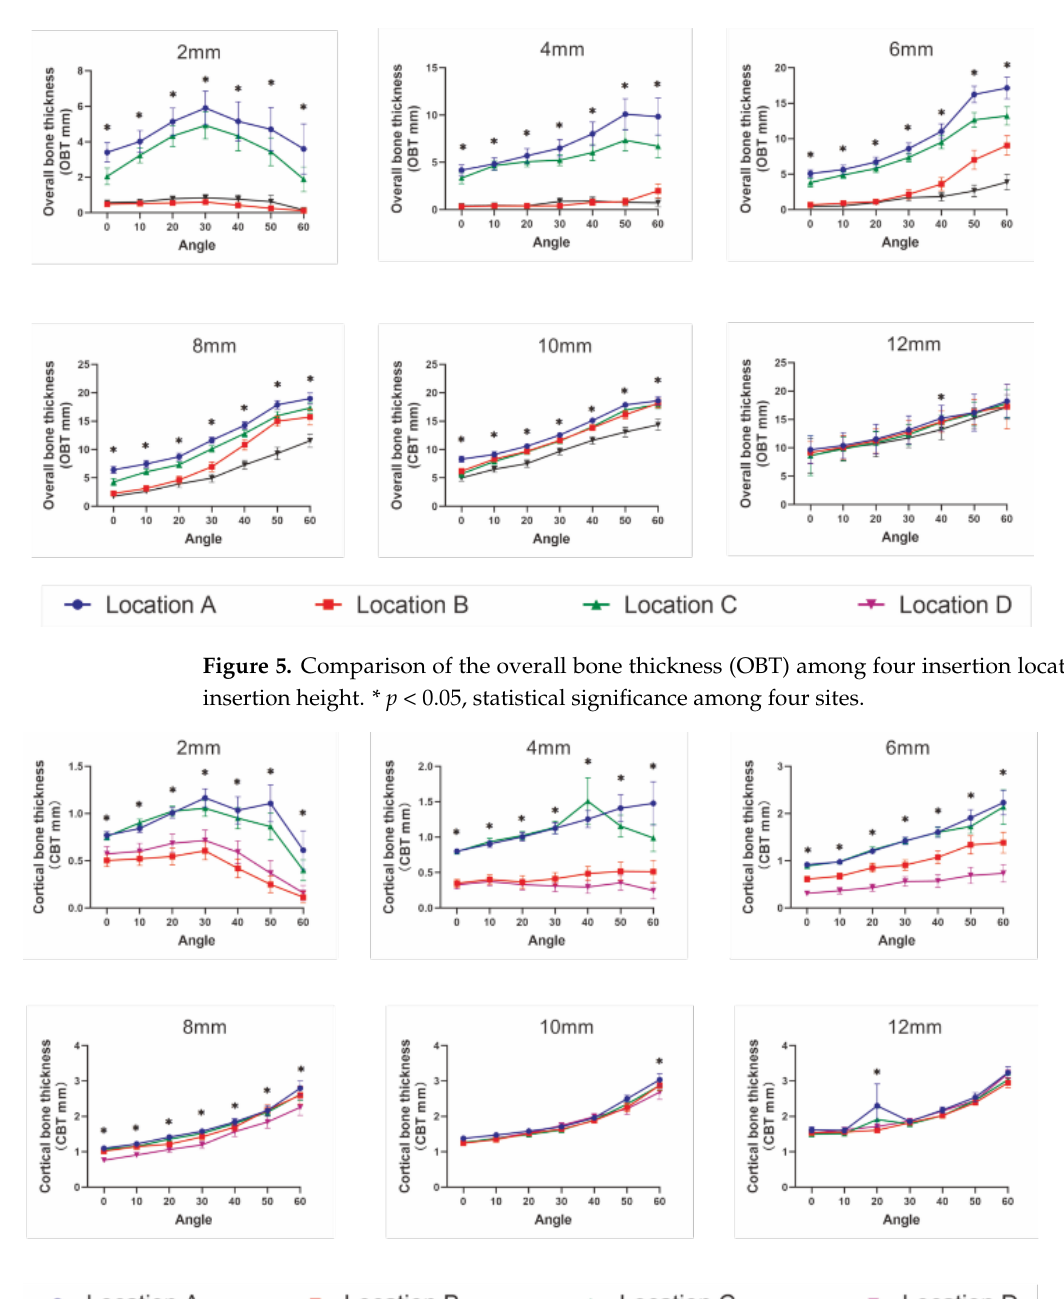
Figure 4. Comparisons of OBT and CBT among investigated locations. ( a ) Comparison of OBT among four insertion locations. * p < 0.05. ( b ) Comparison of CBT among four insertion locations. * p < 0.05.